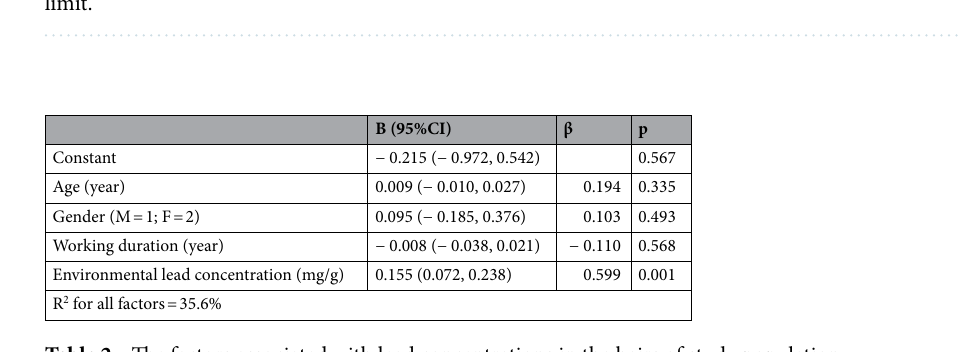
Table 2. The factors associated with lead concentrations in the hairs of study